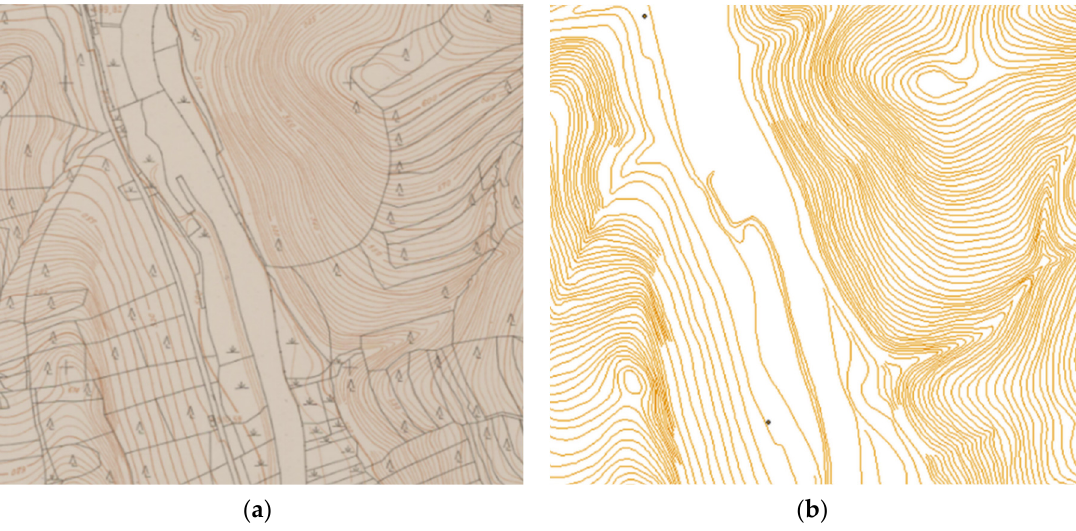
Figure 3. State Map 1:5000-Derived : ( a ) example of a part of a georeferenced scan of a map sheet used for the automatic vectorisation of elevation contours; ( b ) vectorised elevation contours from the map piece shown in ( a )